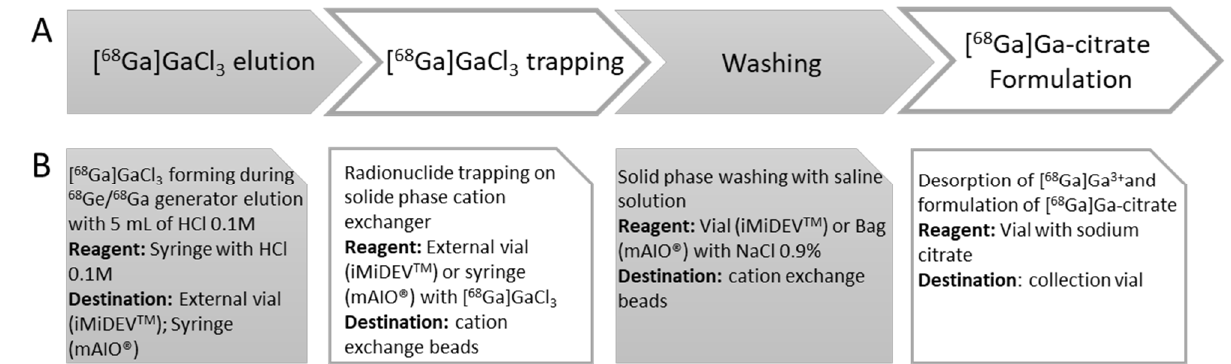
Figure 7. Workflow for automated [ 68 Ga]Ga-citrate production using miniAIO ® and iMiDEV™ modules. ( A ) Overview of main steps of [ 68 Ga]Ga-citrate production. ( B ) Card panels represent basic processes needed to achieve each of main steps of production.